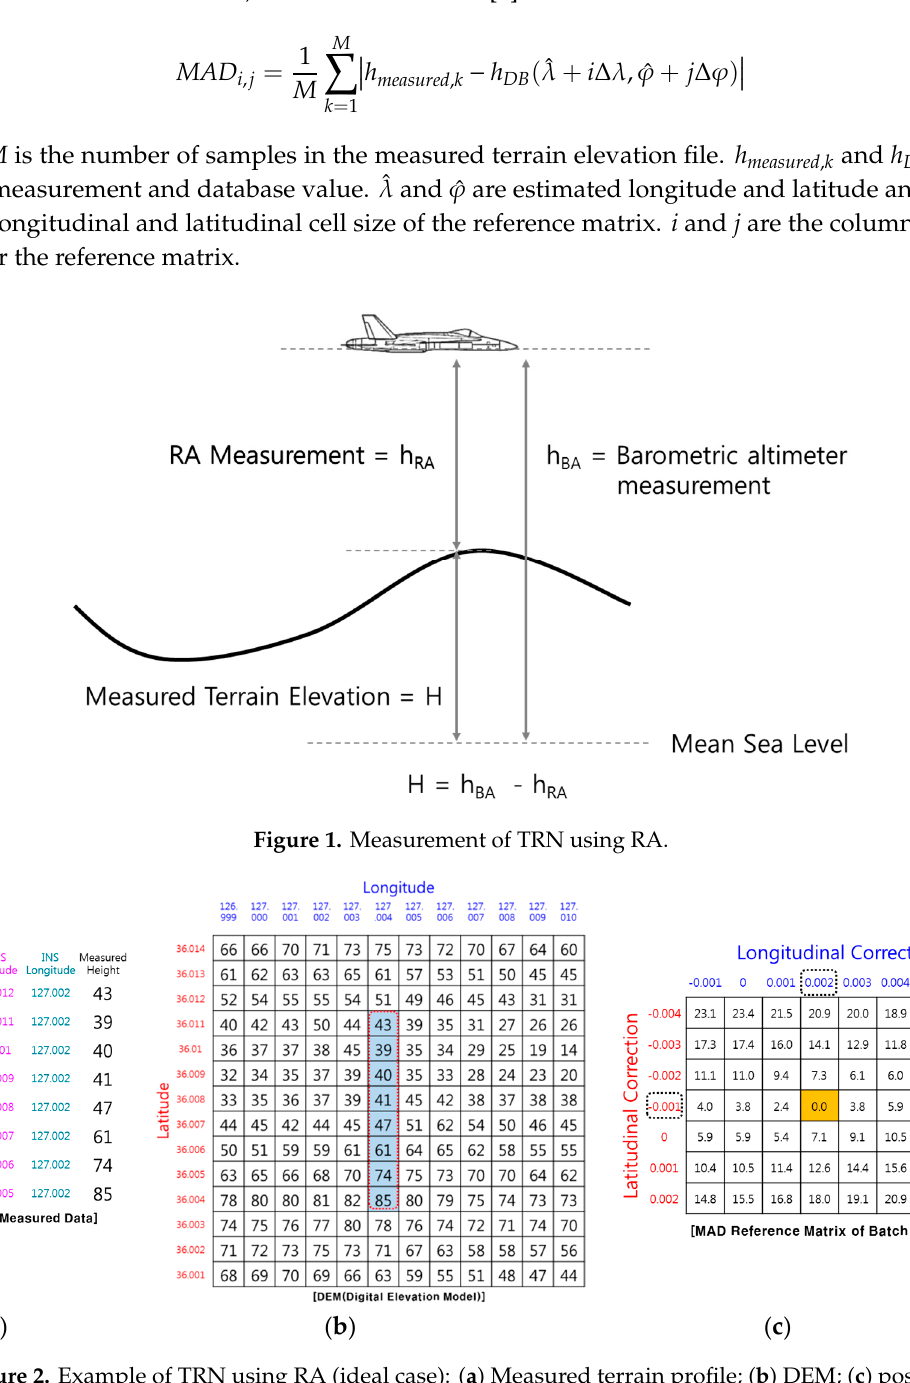
Figure 2. Example of TRN using RA (ideal case): ( a ) Measured terrain profile; ( b ) DEM; ( c ) position correction value.